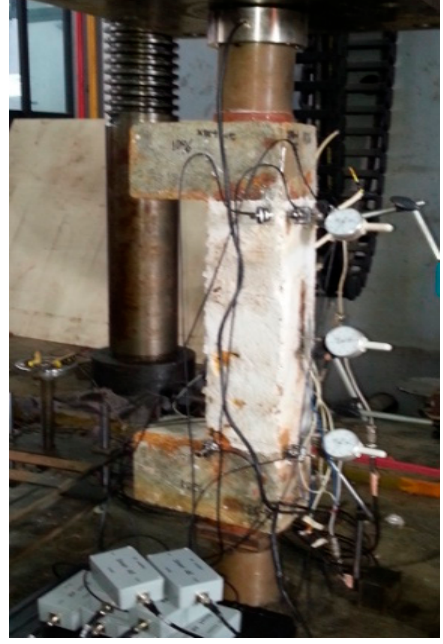
Figure 3. Schematic of the test system. (Abbreviation: acoustic emission (AE))